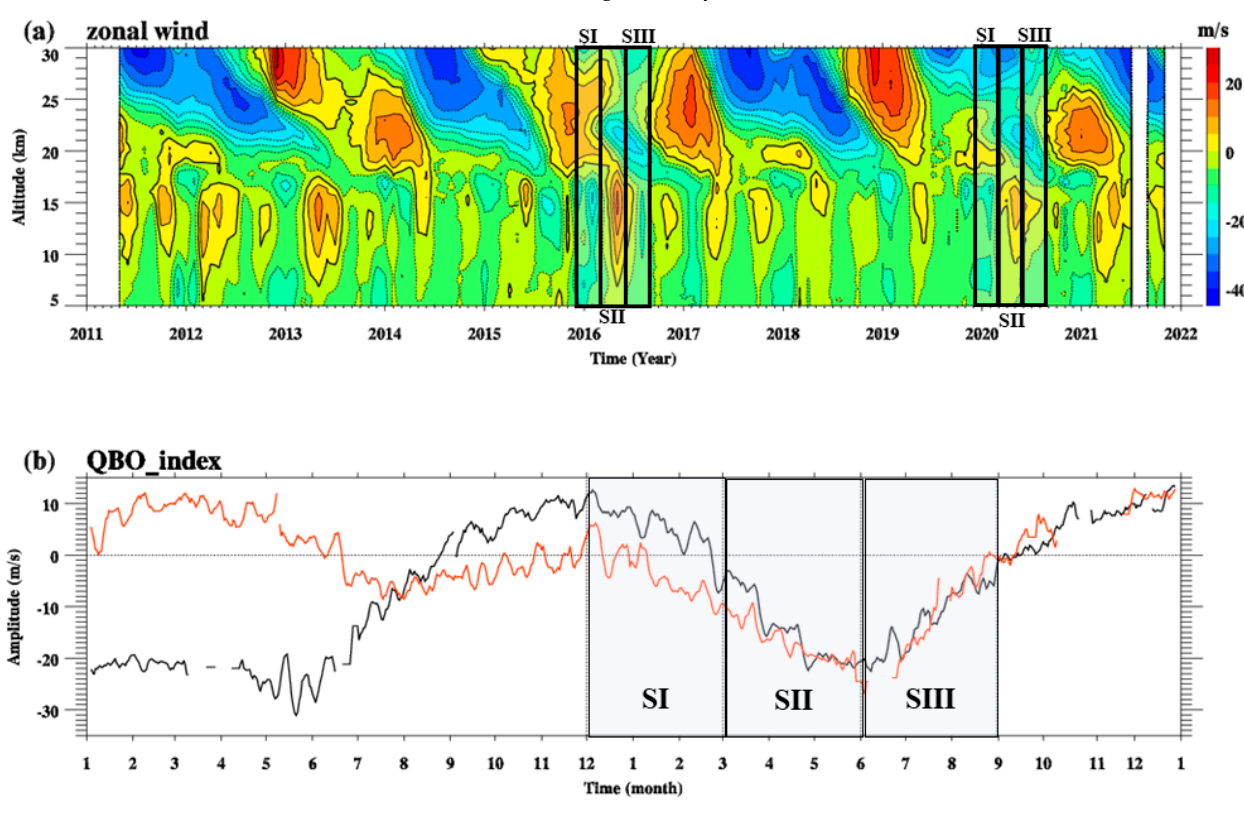
Figure 1. ( a ) Temporal evolution of monthly zonal wind over Ponape Island station (6.97 ◦ N, 158.22 ◦ E). Panel ( b ) denotes the daily time series of the averaged zonal wind from 21 km to 23 km over Ponape Island station (6.97 ◦ N, 158.22 ◦ E) in 2015/2016 (black line) and 2019/2020 (red line). The solid and dotted contours denote the eastward and westward winds, respectively, with a contour interval of 5 m/s in ( a ). The thick contours represent zero zonal wind. The blanks denote no observational data. The horizontal dashed line in panel ( b ) denotes the speed of 0 m/s. The black and red lines denote the QBO index for 2015/2016 and 2019/2020, respectively. Boxes indicate SI, SII, and SIII stages in panels ( a , b ).